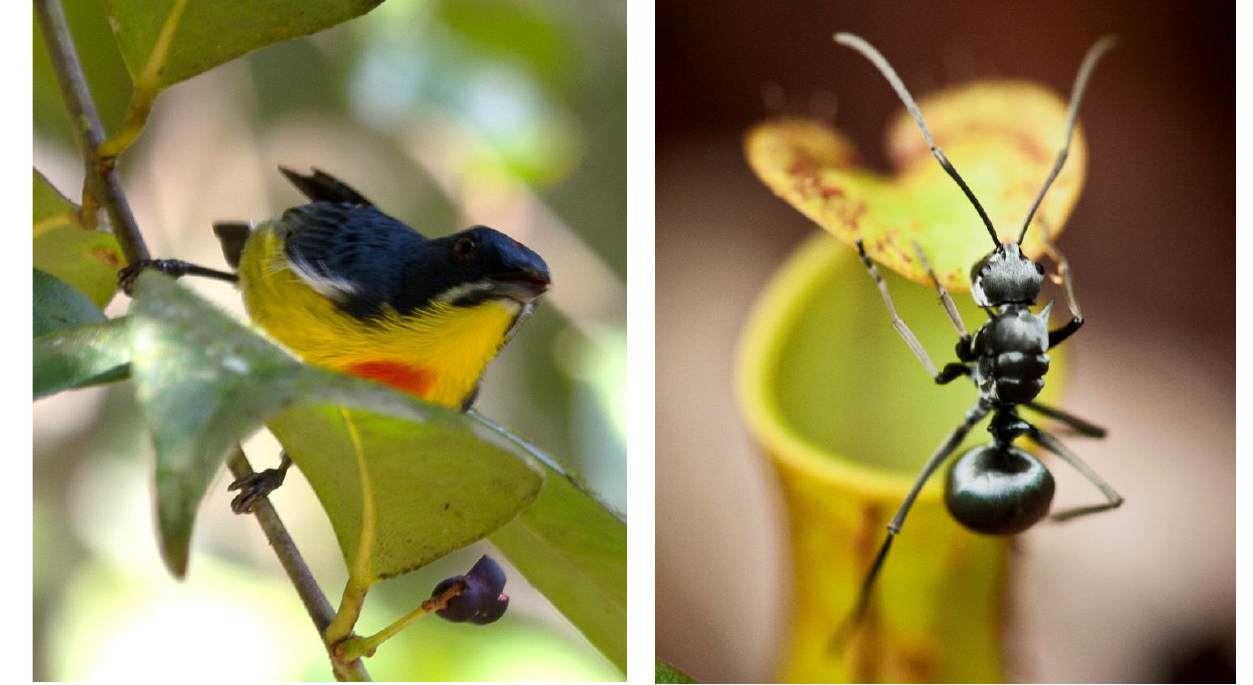
Figure 2. Left: the crimson-breasted flowerpecker ( Prionochilus percussus ); photo Eric Perlett / BNF. Right: spiny ant Polyrhachis ( Myrma ) sp.; photo Christopher Owen /